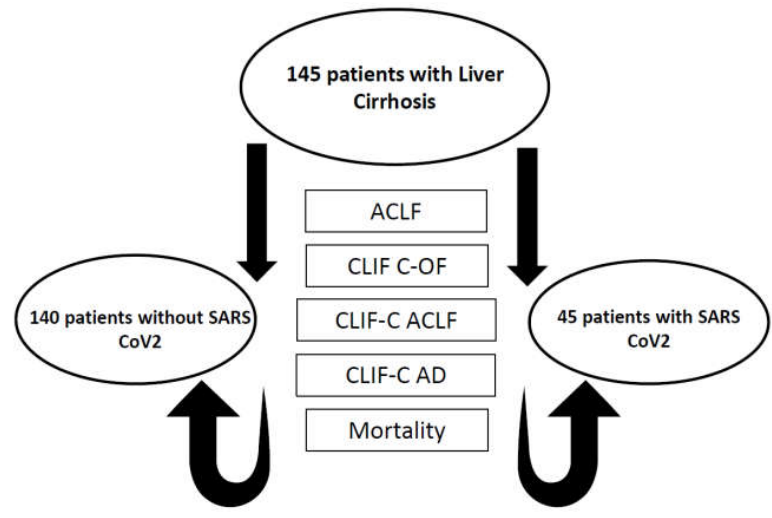
Figure 1. Flowchart of patient parameters evaluated in the study. AD: acute decompensation; ACLF: acute-on-chronic liver failure; CLIF-C AD: sequential organ failure assessment, acute decompensation; CLIF-C ACLF: sequential organ failure assessment, ACLF; CLIF-C OF: sequential organ failure assessment, organ failure.